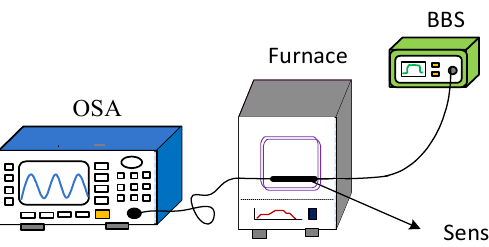
Figure 10. Temperature sensing experimental device schematic diagram.